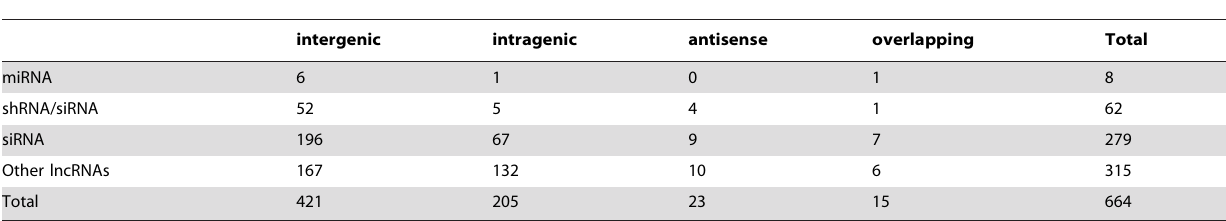
Table 3. Classification of 664 drought-responsive